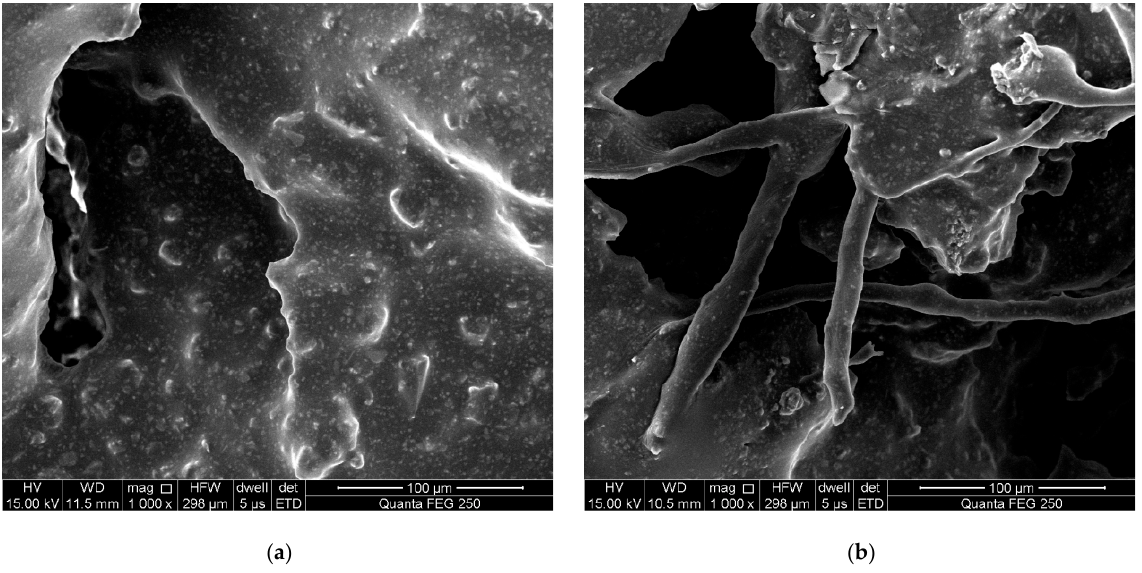
Figure 7. Failure interface of SCB test of different asphalt mixtures: ( a ) non ‐ fiber (×1000) and ( b ) biomass fiber ‐ reinforced (×1000).